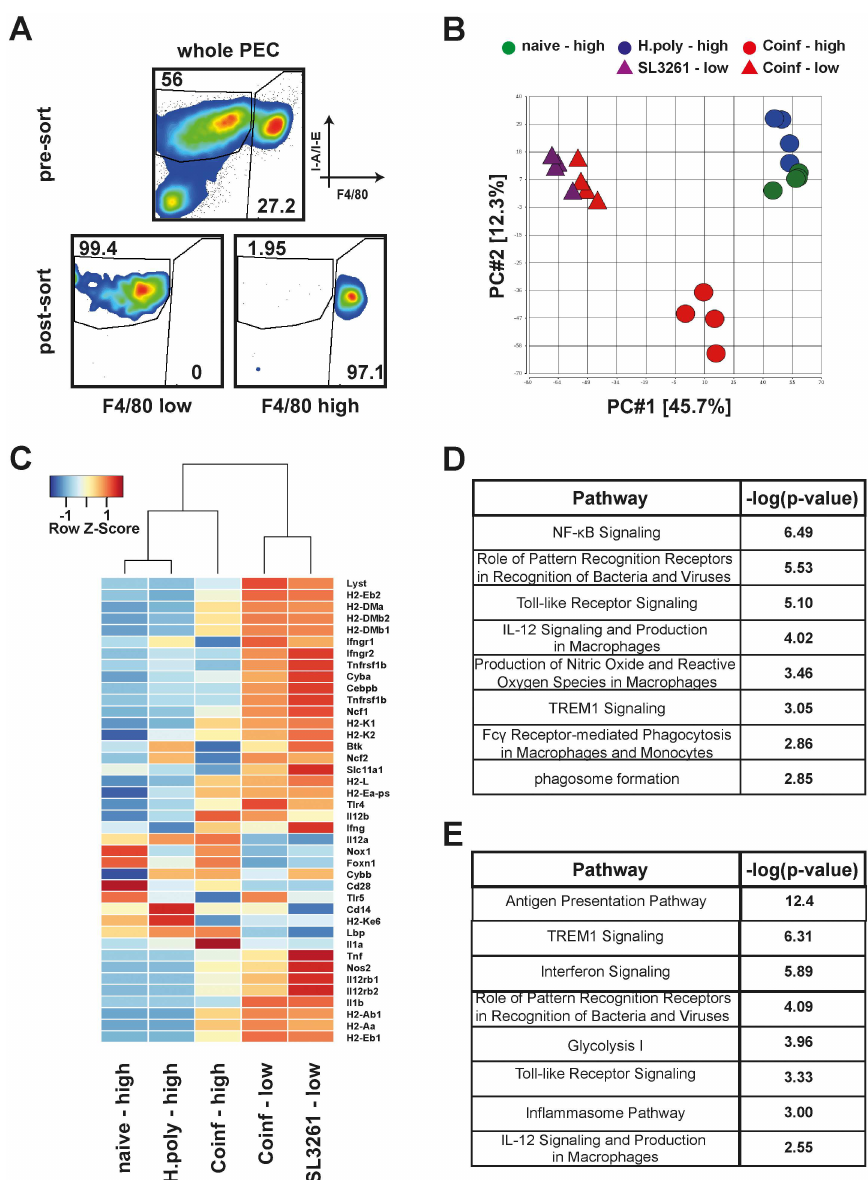
Fig 5. Microarray analysis of M Φ populations from single and co-infected animals. A) Representative dotplots depictingunsorted and sorted M Φ populations. Tissue residentderived, F4/80 high and monocyte- derived F4/80 low M Φ were identifiedas lineage negative (Ly6G-, TCR β -, SiglecF-, CD19-) CD115+F4/80 high or low, respectively,and sorted by fluorescence activated cell sorting reachingpuritiesof > 96%. B) Principalcomponentanalysisof globalgene expressionin F4/80 high (circle) or F4/80 low (triangle) M Φ from naive (green), singleH. polygyrus(blue), SL3261(purple)or co-infected(red) animals. C) Hierarchical clusteringand heatmapof genes associated with resistanceto SL3261. D) Selectedcanonicalpathways determined by IPA, significantly enrichedfor DE genesin pairwisecomparisons of F4/80 low and F4/80 high M Φ from co-infectedanimals. E) As D) in pairwisecomparisons of F4/80 high M Φ from co-infectedanimals comparedto single H . polygyrus infected